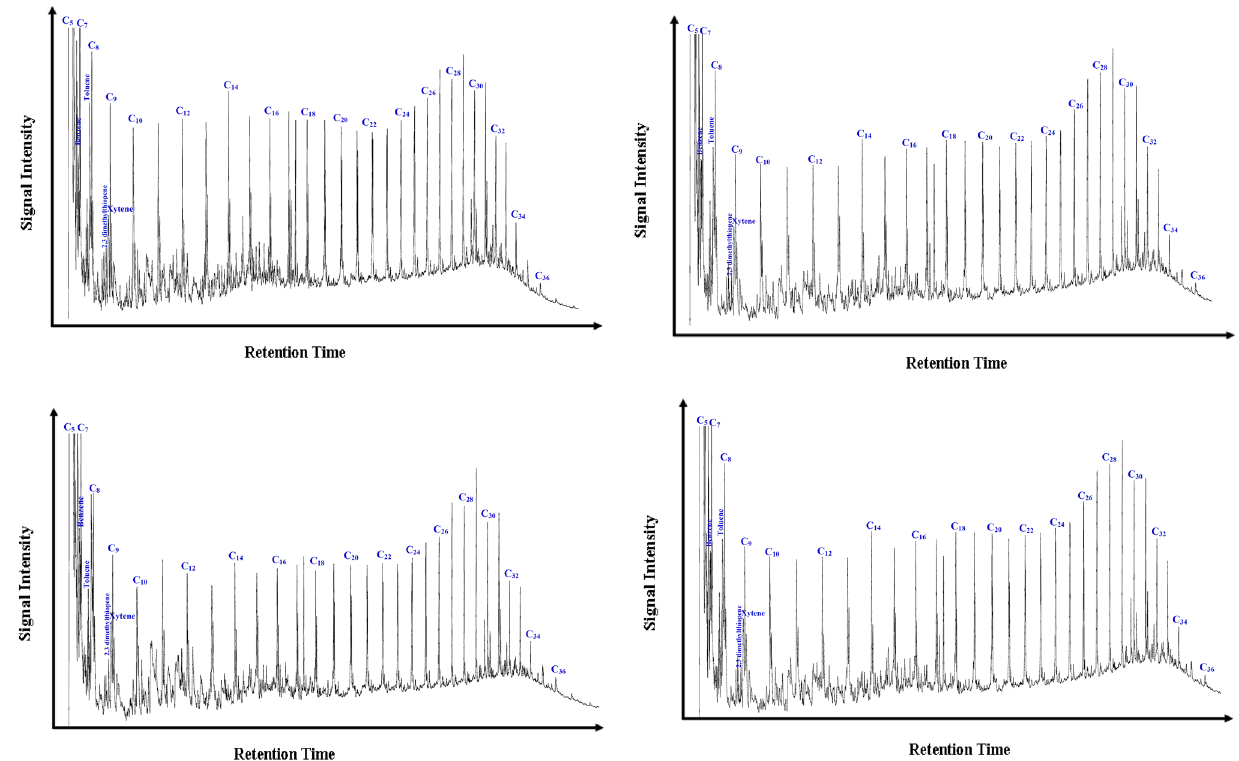
Fig. 5 Pyrolysis GC pyrograms of the four analyzed bituminite shale samples, showing labeled peaks of n -alkene and n -alkane doublets, sulfur-lean organic matter, and aromatic hydrocarbons (toluene,